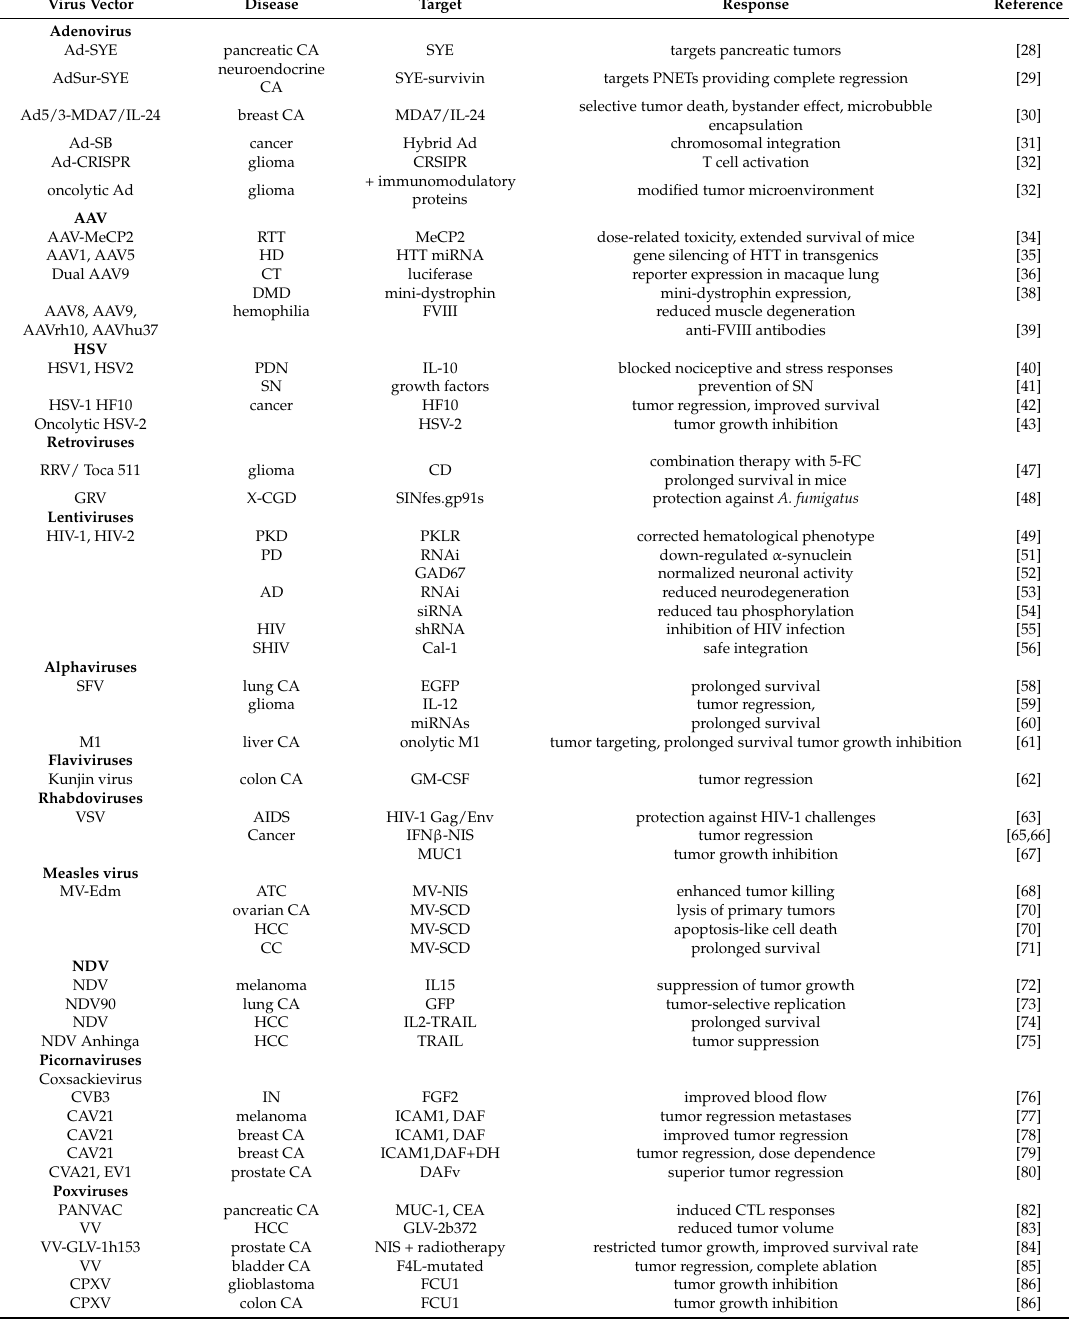
Table 2. Examples of gene therapy applications in animal